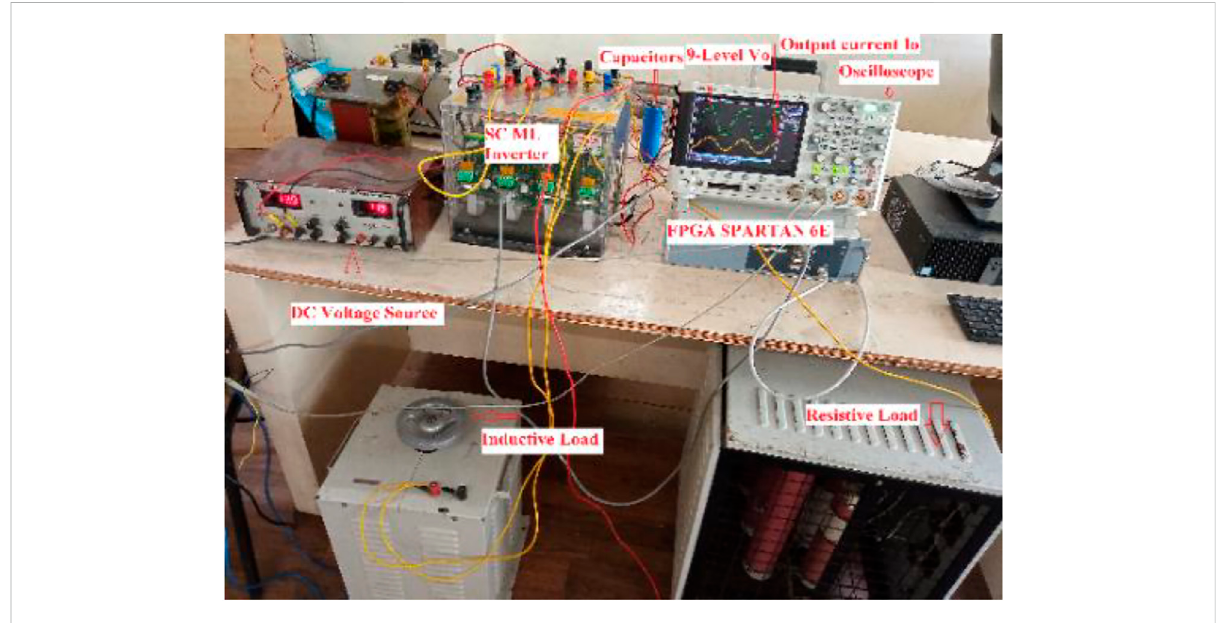
FIGURE 12 Experimental setup for the seven-level DSTATCOM.